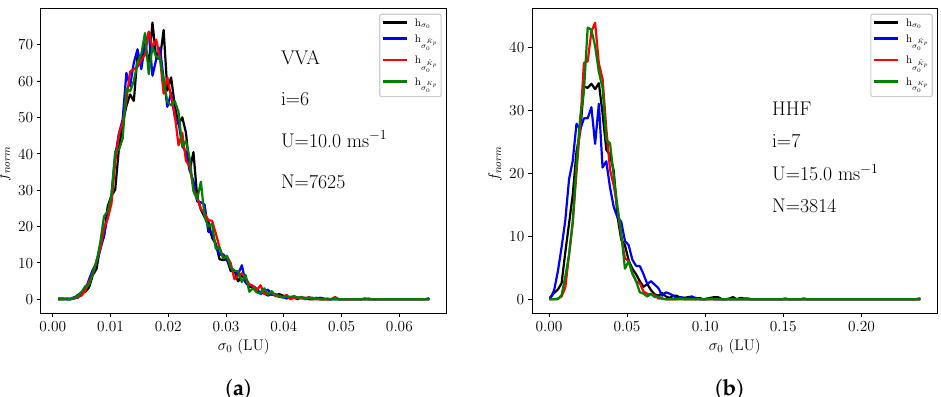
Figure 10. In each plot, the solid curve represents the normalized histogram of the real σ 0 s in linear units (LU) of the orbit with number 40,651, while the dashed (dotted) line represents the normalized histogram of the σ 0 s simulated using K EMP p ( K MED p ) in the random generator described in Equation (5)). Finally, the dashed–dotted curve shows the simulated σ 0 s obtained using product K p s. Some additional information is reported in each panel, describing the case under examination: the flavor (pol; view) , the slice index, the reference wind speed value and the total number of samples, respectively. The flavor string is composed as follows: HH (VV) stands for HH-Pol (VV-Pol) and A (F) stands for aft (fore).